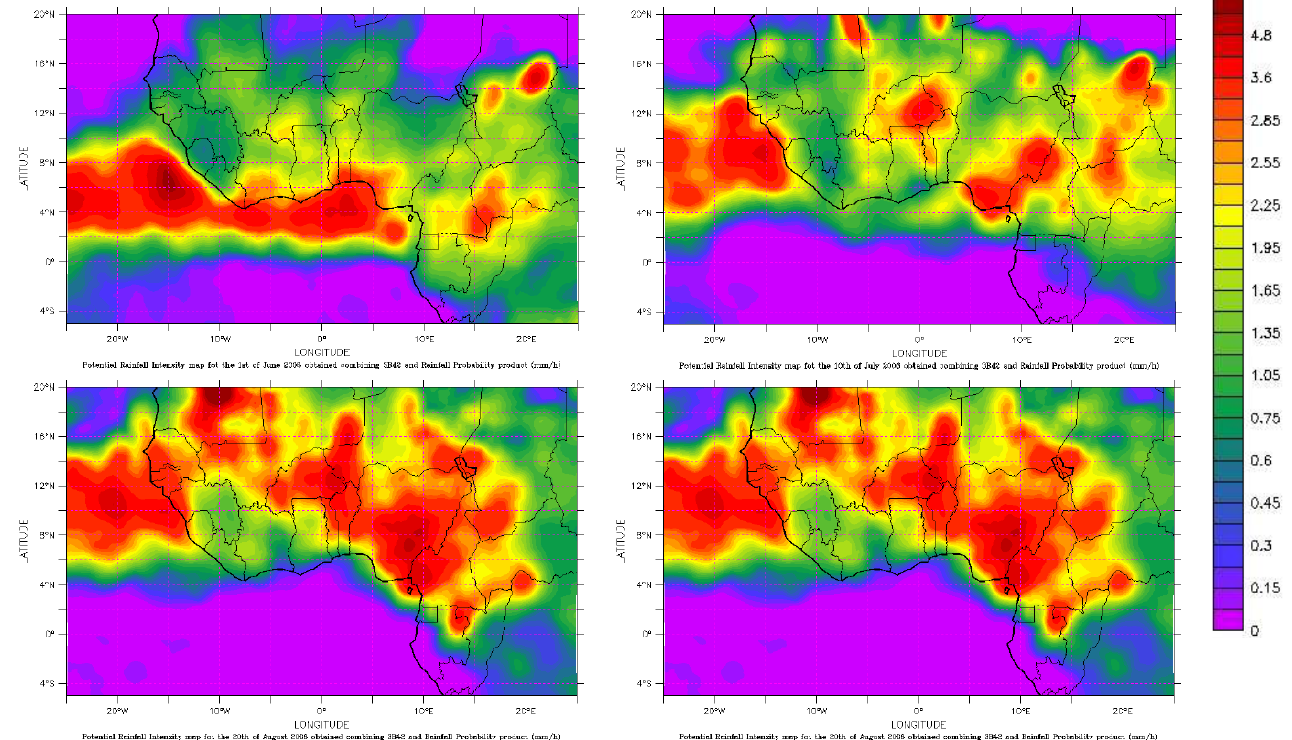
Fig. 12. EPSAT-SG daily rainfall potential intensity maps computed with 3B42 product instead of GPCP-1dd.